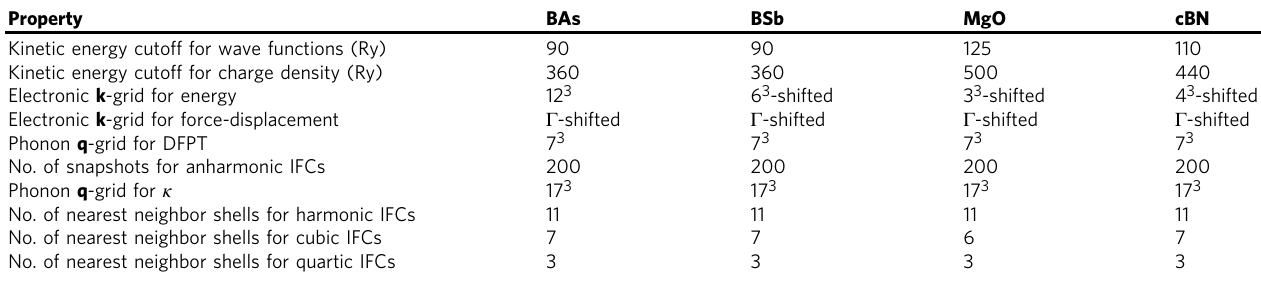
Table 1 Converged values of the fi rst-principles computational